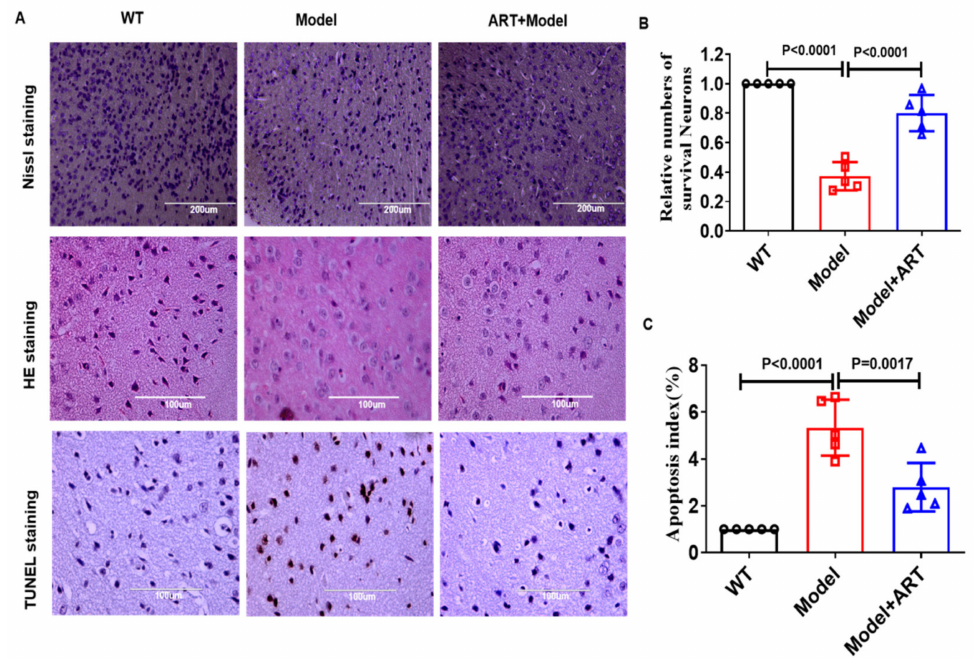
Figure 7. Artemisinin treatment reduced cell damage in the AD mouse model. ( A ) HE staining showed the histopathological changes of neurons in C57 model mice; Nissl staining was used to check the apoptosis of the Nissl body; TUNEL staining was used to check the apoptosis of neuronal cells in different groups. ( B ) Statistical analysis results of Nissl staining. ( C ) Statistical analysis results of TUNEL staining. p < 0.05 was considered significantly